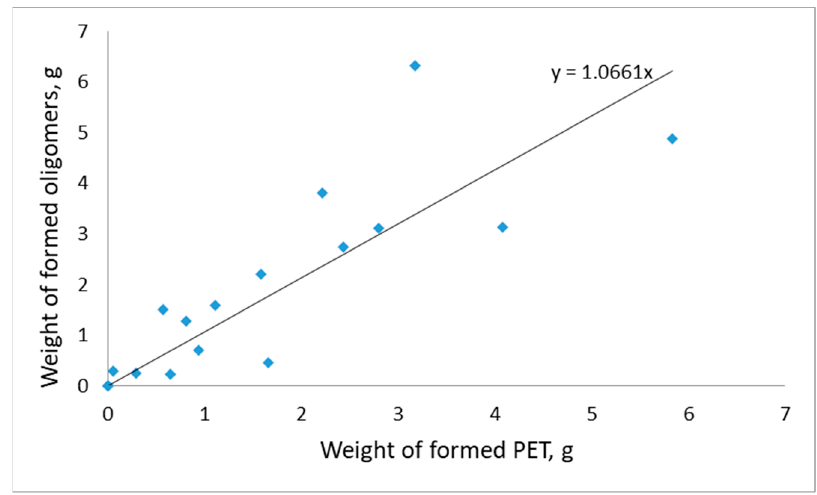
Figure 4. There is a correlation between the decrease in determined potassium ions and the amount of PET dissolved in pure glycerol for different initial molar ratios of PET/KSt at 170 °C. Horizontal lines are total amounts of PET; vertical lines are total amounts of KSt.